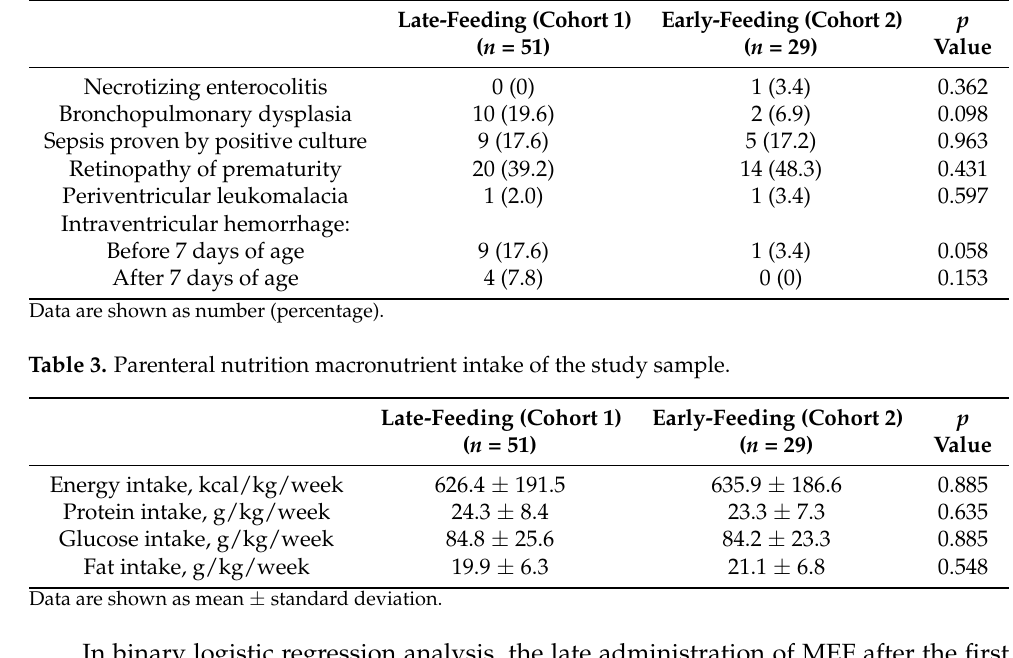
Table 2. Morbidity during hospital stay of the study sample.